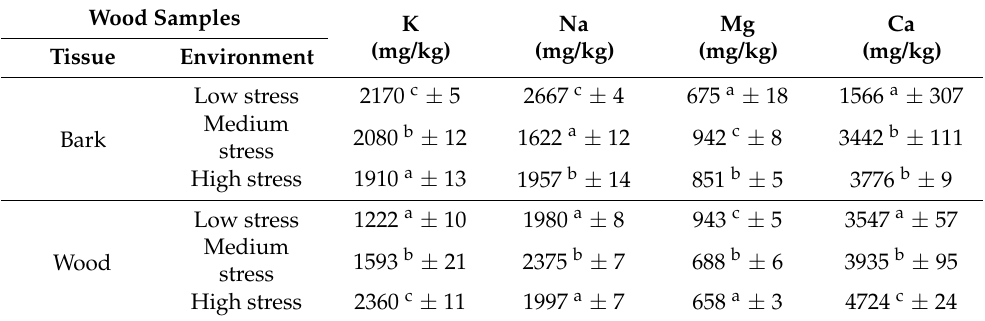
Table 2. Chemical composition of elements (K, Na, Mg, Ca) in Tilia cordata Mill. (bark and wood). Wood Samples K (mg/kg)